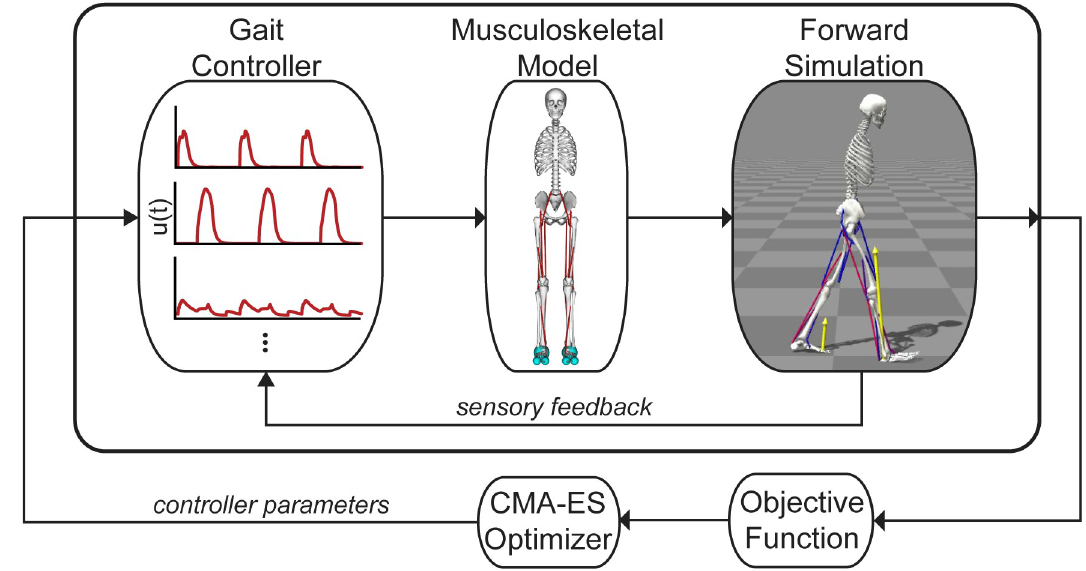
Fig 1. Single shooting framework for dynamic optimization. We trained a planar, musculoskeletal model actuated by 18 Hill-type musculotendon actuators to walk by optimizing the parameters of a gait controller based on an objective function that sought to minimize metabolic cost, avoid falling and injury, and stabilize the head. The gait controller computed muscle excitations, u(t) , for a musculoskeletal model to generate a forward simulation. Sensory feedback, based on the model’s muscle and joint states, was used in a feedback loop with the gait controller. The objective function quantified the performance of each simulation, and a Covariance Matrix Adaptation Evolutionary Strategy (CMA-ES) optimization method updated the values of the variables in the optimization